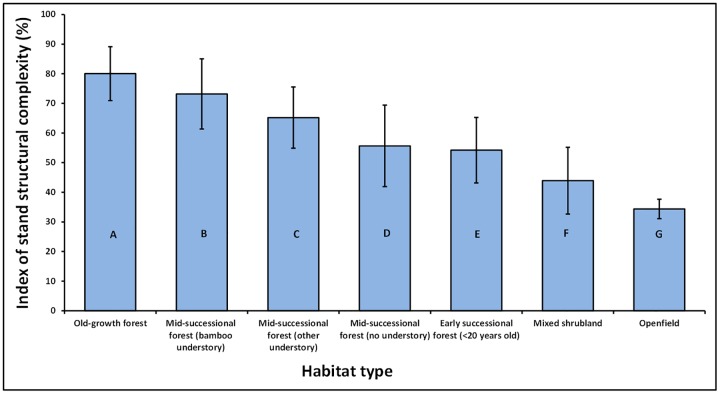
Relationship between the mean values of the index of stand structural complexity and seven habitat types.Bars with different letters were significantly different according to a Holm-Sidak post hoc test. Small bars are ± standard deviation.